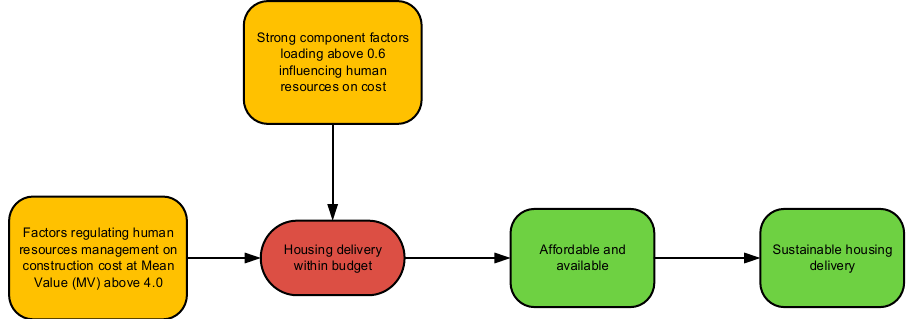
Figure 1. Framework of factors that influence human resources management on cost towards affordable housing delivery. housing